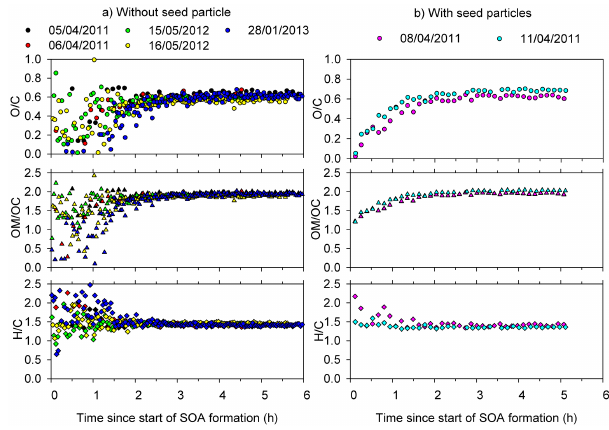
Figure 4. Time profiles of O / C, OM / OC and H / C ratios for seven different isoprene photooxidation experiments performed (a) without seed particle; (b) with ammonium sulfate seed